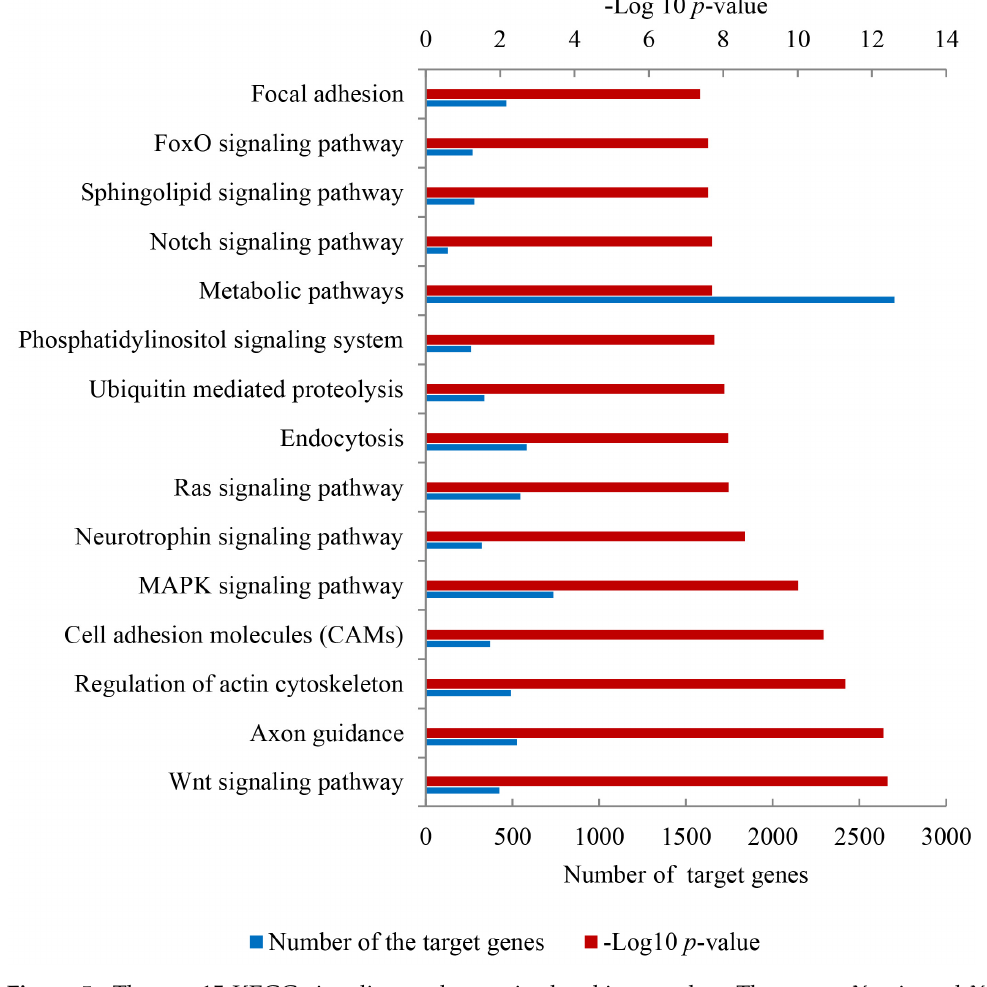
Figure 5. The top 15 KEGG signaling pathways in the skin samples. The upper X-axis and X-axis below represents the calculated results of − Log10 ( p -value) and the amount of the target mRNAs, respectively.